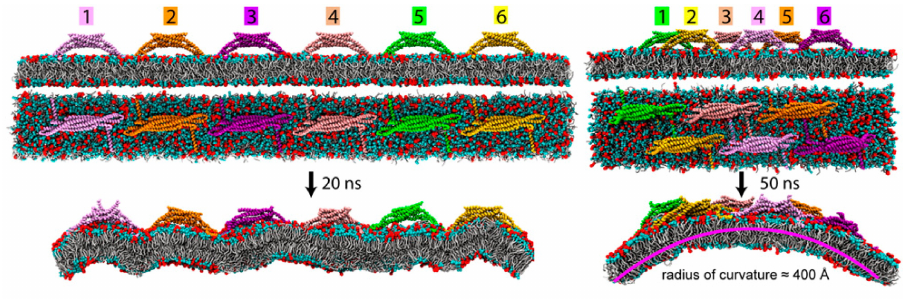
Simulations of six Bin/Amphiphysin/Rvs (BAR) domains remodeling a membrane. These simulations show that the proteins require a staggered arrangement (right) to bend the membrane, while the non-staggered arrangement (left) fails to generate curvature. Figure adapted from Arkhipov, et al.